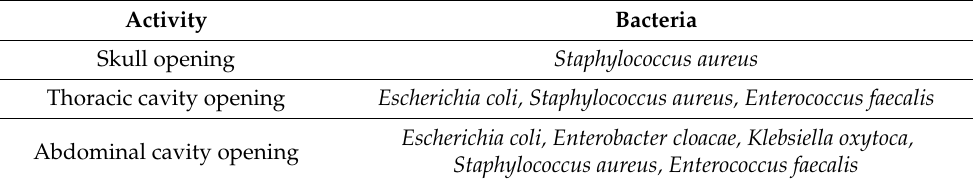
Table 4. Pathogenic bacterial species isolated from air samples collected during the